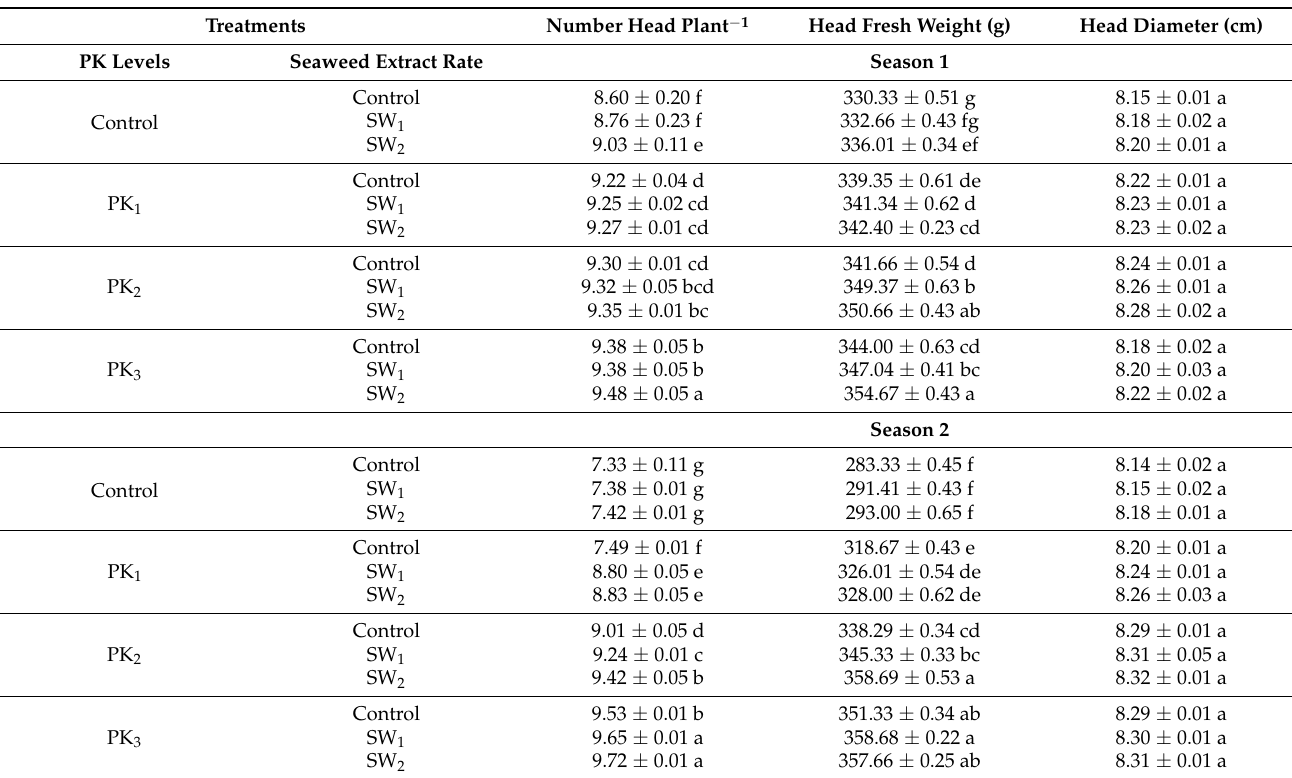
Table 4. Head characteristics of globe artichoke as affected by the interaction between PK fertilizer levels and seaweed extract rate.